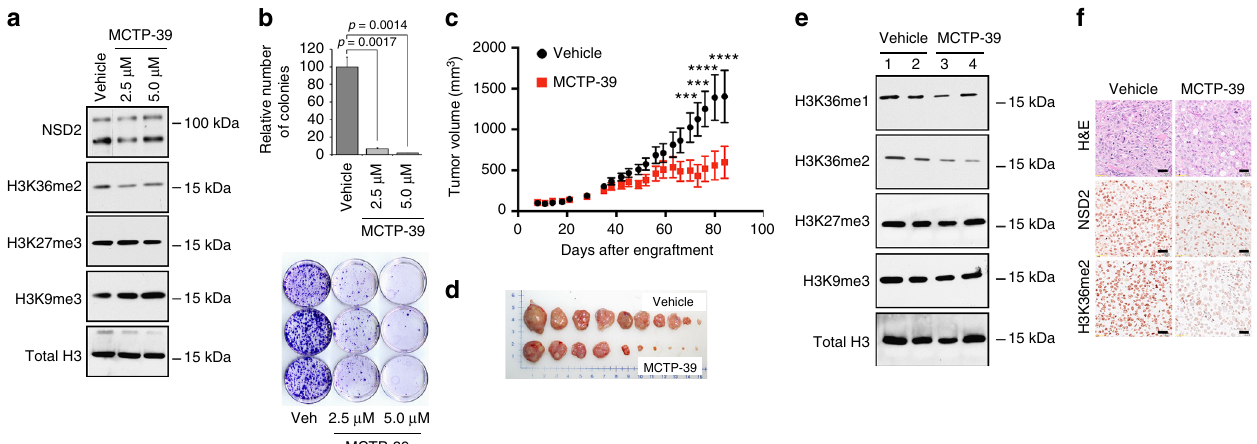
Fig. 7 Pharmacological treatment. a , b Pharmacological treatment in vitro. DU145 cells were treated with MCTP-39 at the indicated concentrations for 72 h. Panel a shows western blot data using the indicated antibodies. The position of a molecular marker is shown; uncropped images are provided in Supplementary Figure 6. b depicts colony forming assays showing quanti fi cation (top) and representative images (bottom). Shown are representative data from 3 independent experiments, each done in triplicate. Error bars represent the standard deviation (s.d.) from the mean; p -values were calculated using a two-tailed Student's t -test. c – f Pharmacological treatment in vivo. DU145 cells (5 × 10 6 cells) were engrafted subcutaneously into male nude mouse hosts. After 1 week of growth, the tumor-bearing mice were randomized by cage to the vehicle (black) or MCTP-39 (red) treatment groups and treated with 10 mg/kg with MCTP-39 (or vehicle only) for up to 3 months. Tumor volume was monitored using calipers and calculated using the formula [Volume = (width) 2 x length/2]. Total mice analyzed for vehicle were 14 and for MCTP-39-treatment were 15 in two independent experiments. c Tumor volume. Two- way analysis of variance (ANOVA) was used to calculate the signi fi cance ( p -value) of the difference between the vehicle and treatment group; *** p < 0.001 and **** p < 0.0001. d Representative tumors collected at at the time of euthanasia. e Western blot showing 2 examples from vehicle (lanes 1, 2) and MCTP-39 (lanes 3, 4) treated tumors using the indicated antibodies (total n = 4/group). The position of a molecular marker is shown; uncropped images are provided in Supplementary Figure 6. f Representative immunostaining for NSD2 and H3k36me3 from vehicle and MCTP-39 treated mice ( n = 4/ group). Scale bars represent 50